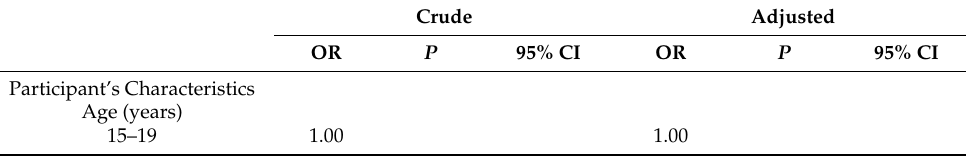
Table 4. Factors associated with women’s willingness to provide digital fingerprints (N =